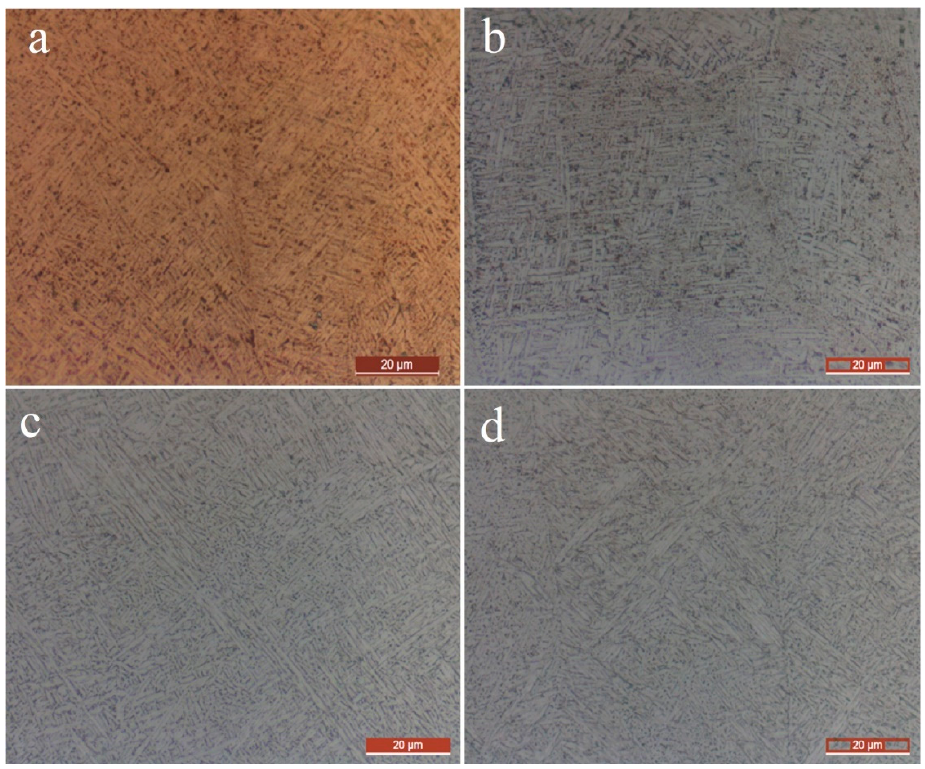
Figure 10. Optical images of microstructures in the top region (last deposited layer) for the a – d sample disks.